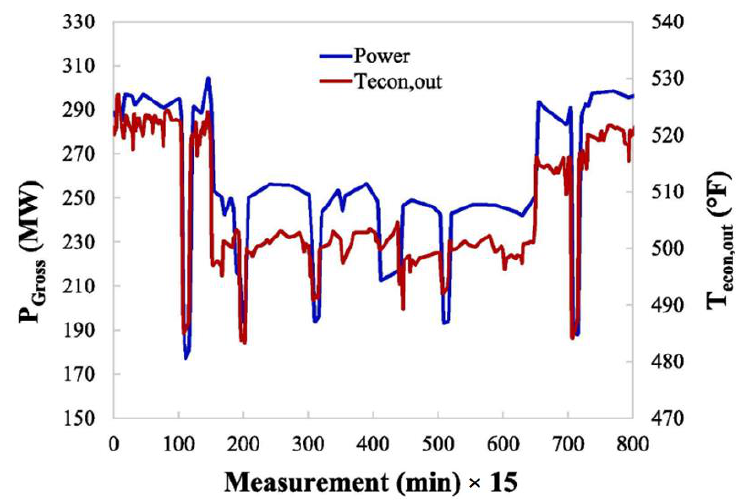
Figure 9. Consequence of a Leak: A Graph Showing the Decrease in Economizer Outlet Temperature [101].